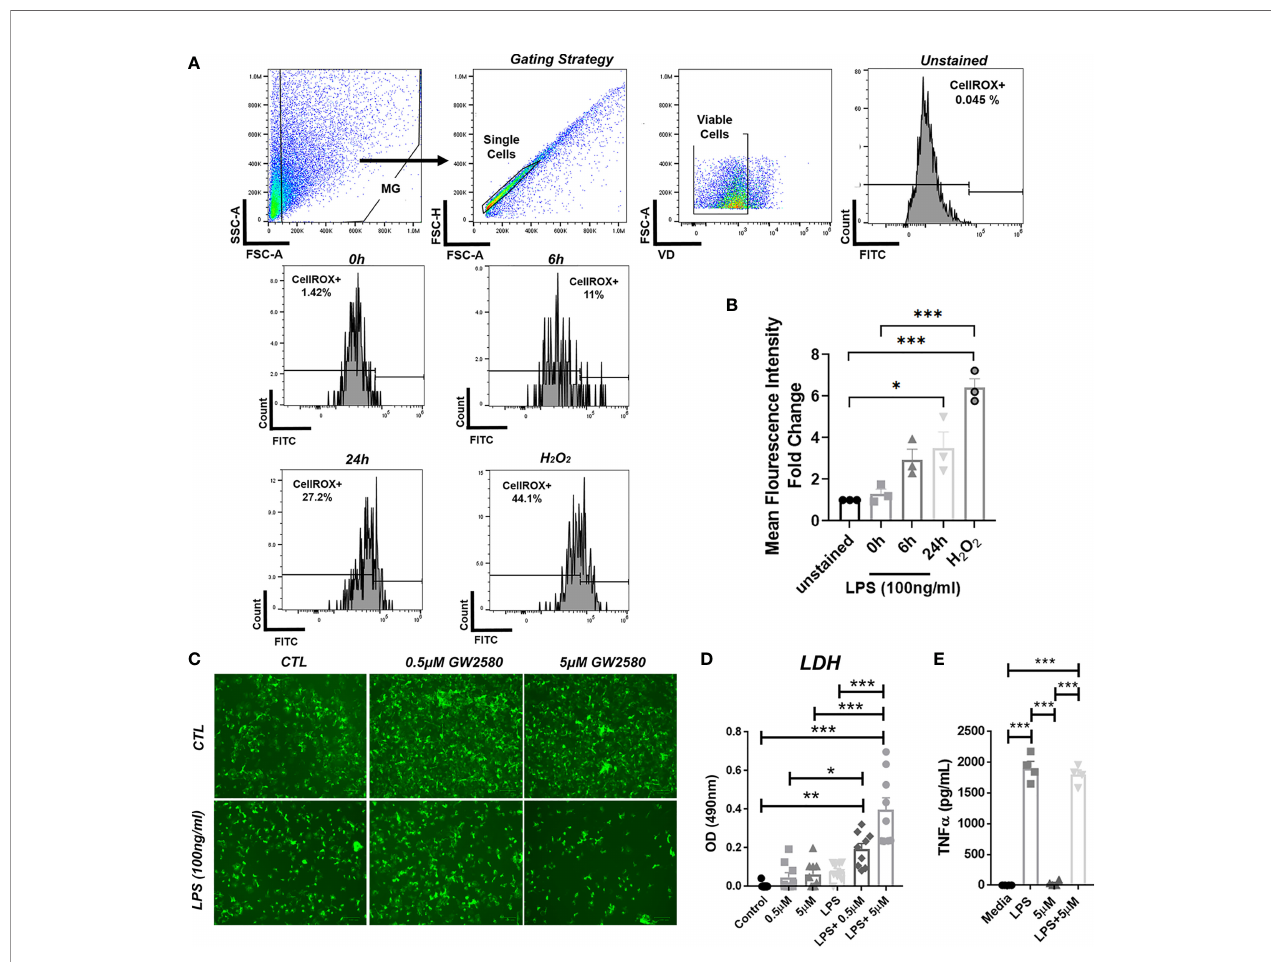
FIGURE 6 | Combined treatment of primary microglia with GW2580 and LPS decreased viability in vitro . (A, B) , Primary microglia were stimulated with LPS (100ng/ ml) for 0, 6 or 24h or with 75µM of H 2 O 2 , for 24h. (A) Microglia were stained for ROS using CellROX and then analyzed by fl ow cytometry to detect changes in fl uorescence intensity. Gating strategy for the experiment. (B) Mean fl uorescent intensity for ROS production after primary microglia stimulation. (C – E) Cells were treated with either media, LPS (100ng/ml), GW2580 (0-5µM), or LPS and GW2580 for 48h. (C) Representative images. (D) Cell death was measured by LDH assay. (E) TNF production by stimulated microglia. Data shown are expressed as means ± standard error (S.E.), n=3 per group for (A) , n=9 per group for (B) and n=4 per group for (C) . Statistical signi fi cance is represented by p-value < 0.05 (*), p-value < 0.01 (**) and p-value < 0.001